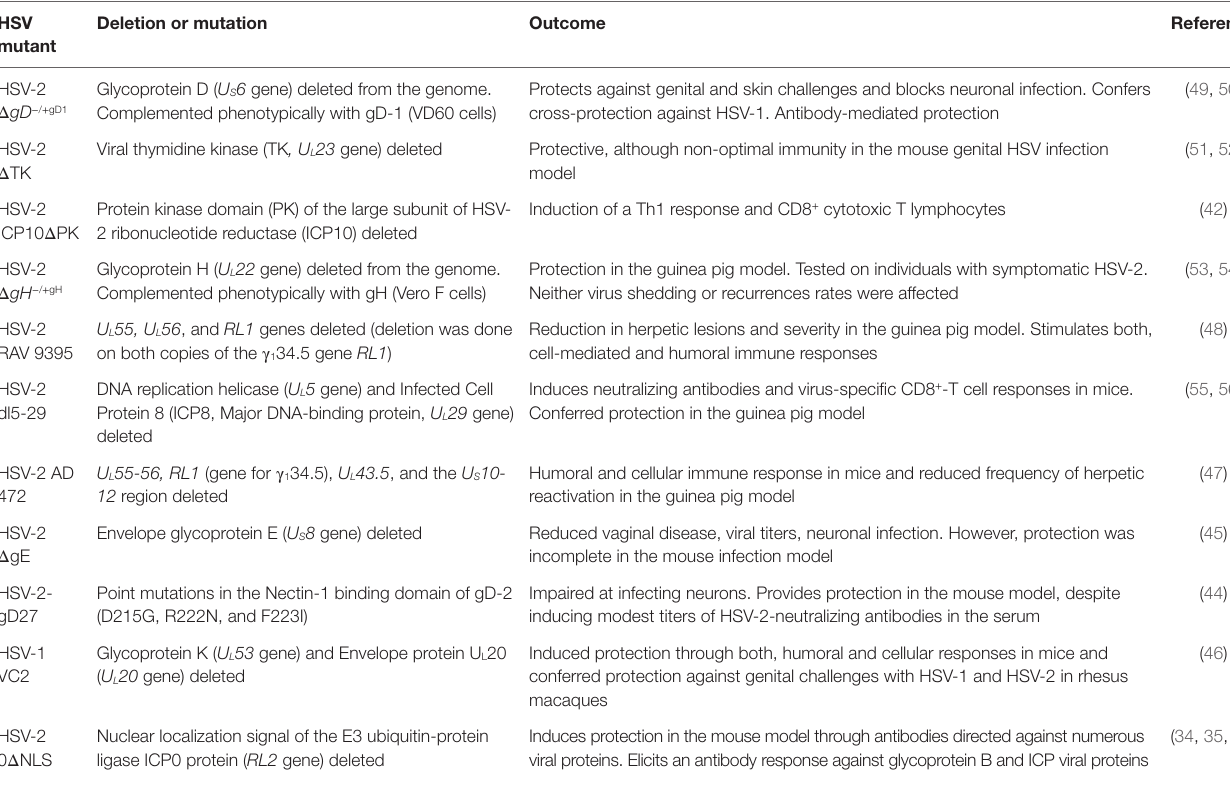
Impaired at infecting neurons. Provides protection in the mouse model, despite inducing modest titers of HSV-2-neutralizing antibodies in the